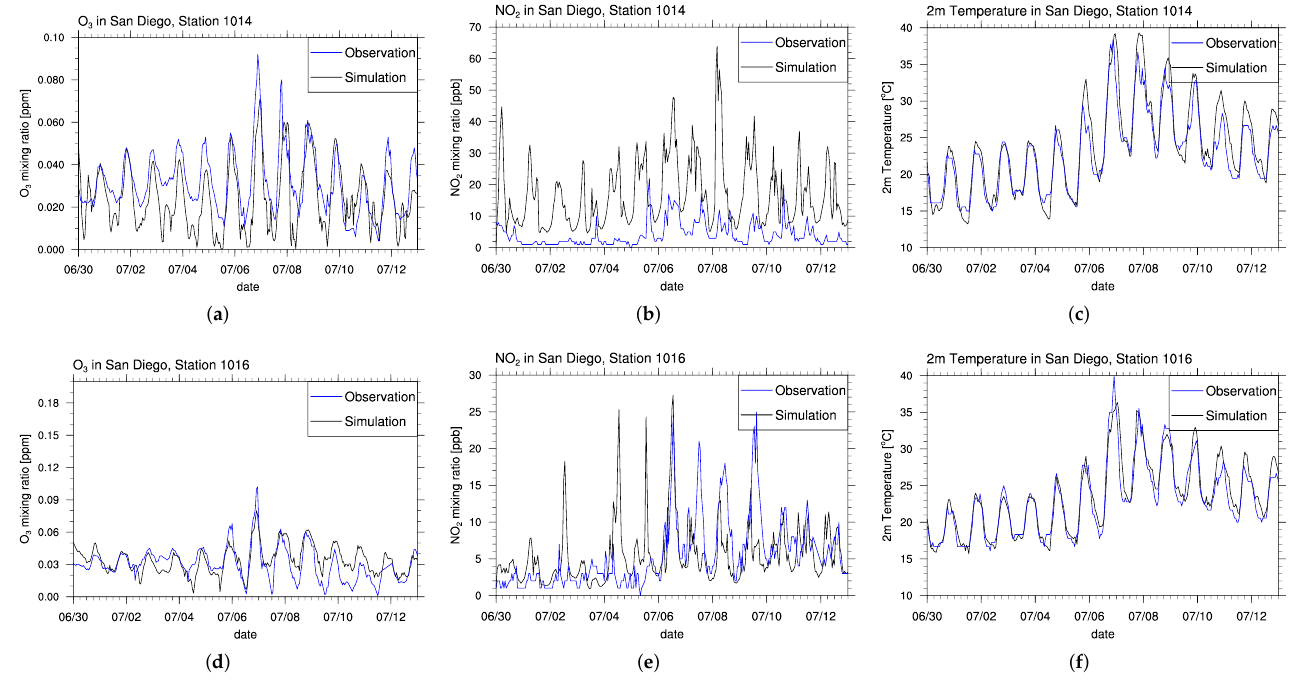
Figure 8. Comparison of in situ measurements with modeled ozone, NO 2 , and T 2 at the ground at San Diego, i.e., Donovan ( a – c ) and Kearny Villa Road ( d – f ) in early July